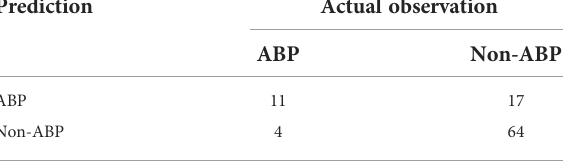
TABLE 3 Accuracy of prediction model in validation cohorts. Prediction